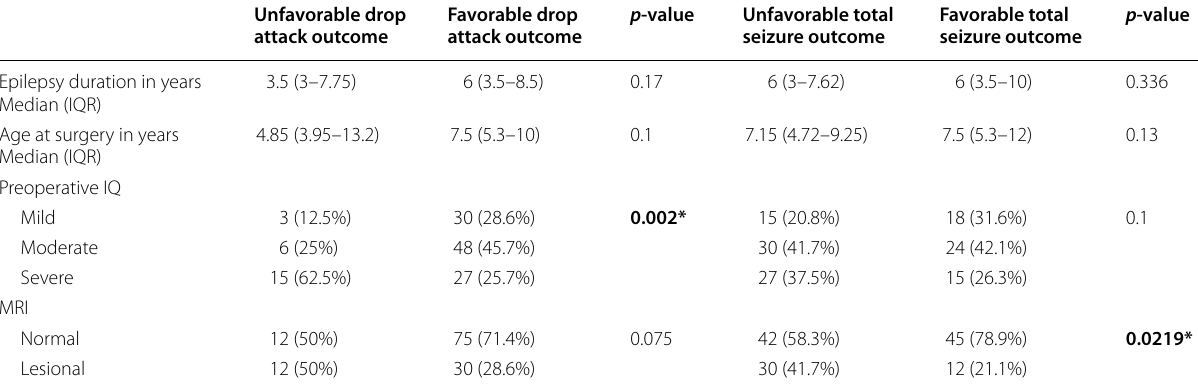
Table 3 Comparison of baseline characteristics between the group of patients with favorable versus unfavorable drop attack and total seizure